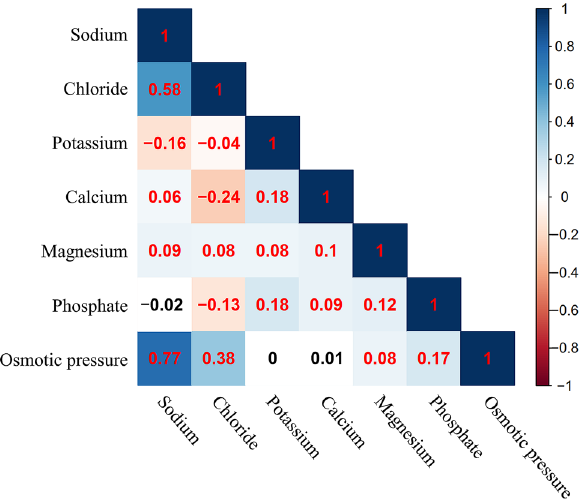
Figure 3. The correlation matrix among the levels of potassium, sodium, chloride, calcium, magnesium, phosphate, and osmotic pressure. The value of correlation coefficient between any of the two variables was marked in the Figure. The correlation coefficients in red indicated that the correlation between two variables is statistically significant ( P < 0.05), while the correlation coefficients in black indicated no statistical